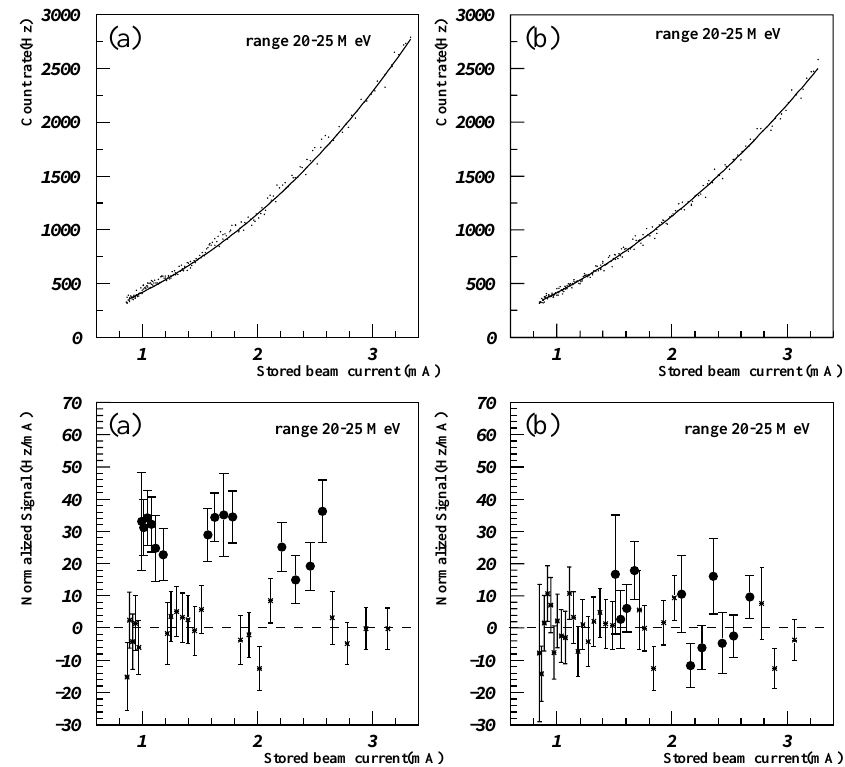
FIG. 3. Examples of the raw count rates as a function of the beam current (the upper plots). The solid lines are fits to the laser-off data by a polynomial function. The background subtracted count rates are shown in the lower plots. The solid circles (cross points) represent the laser-on (off) data. Note that approximately six data points in the upper plots are combined into one to reduce